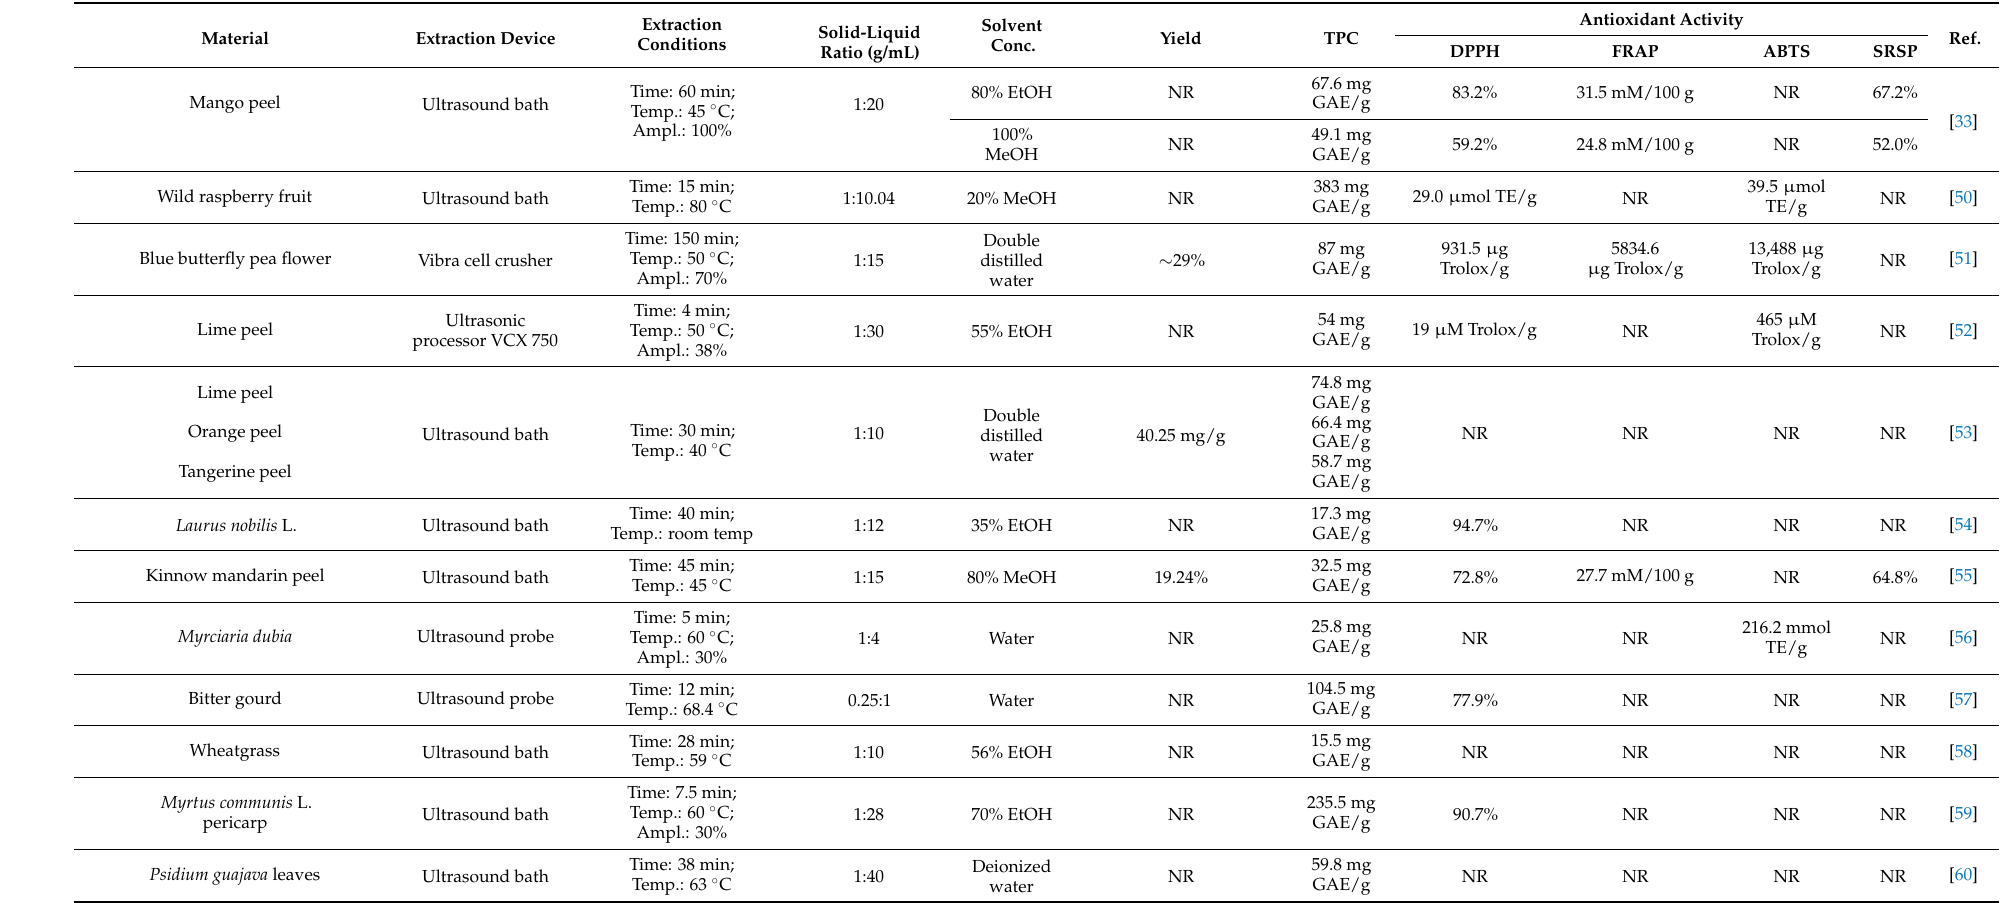
Table 2. Extraction of bioactive (antioxidant) compounds by ultrasonic-assisted